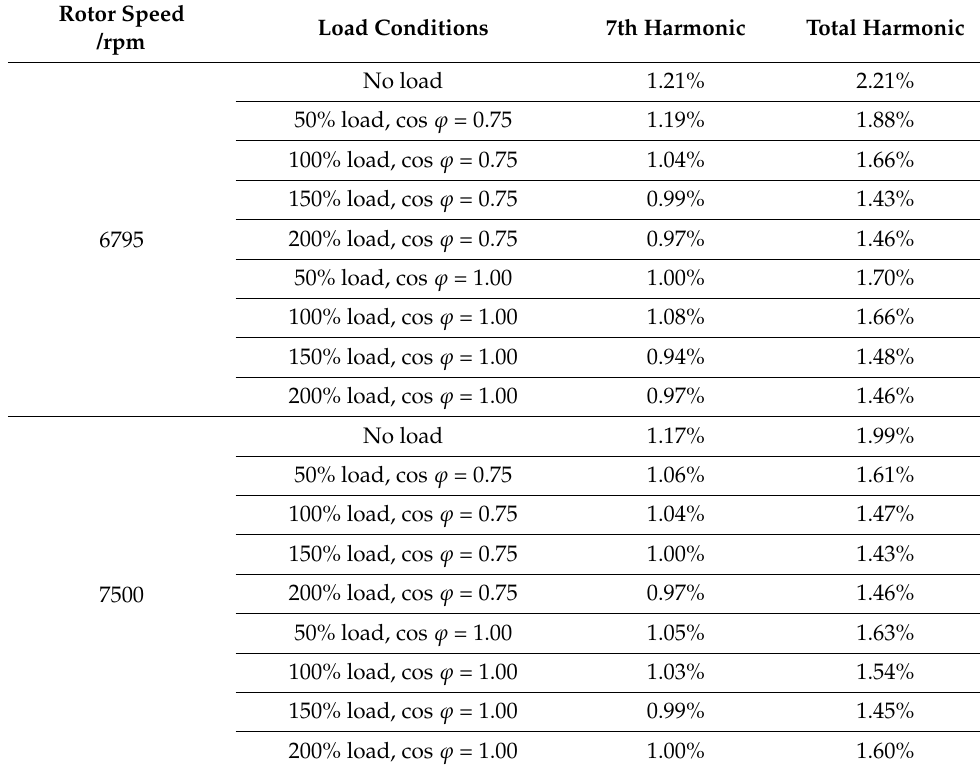
Table 11. Harmonic data of the BSG under different load